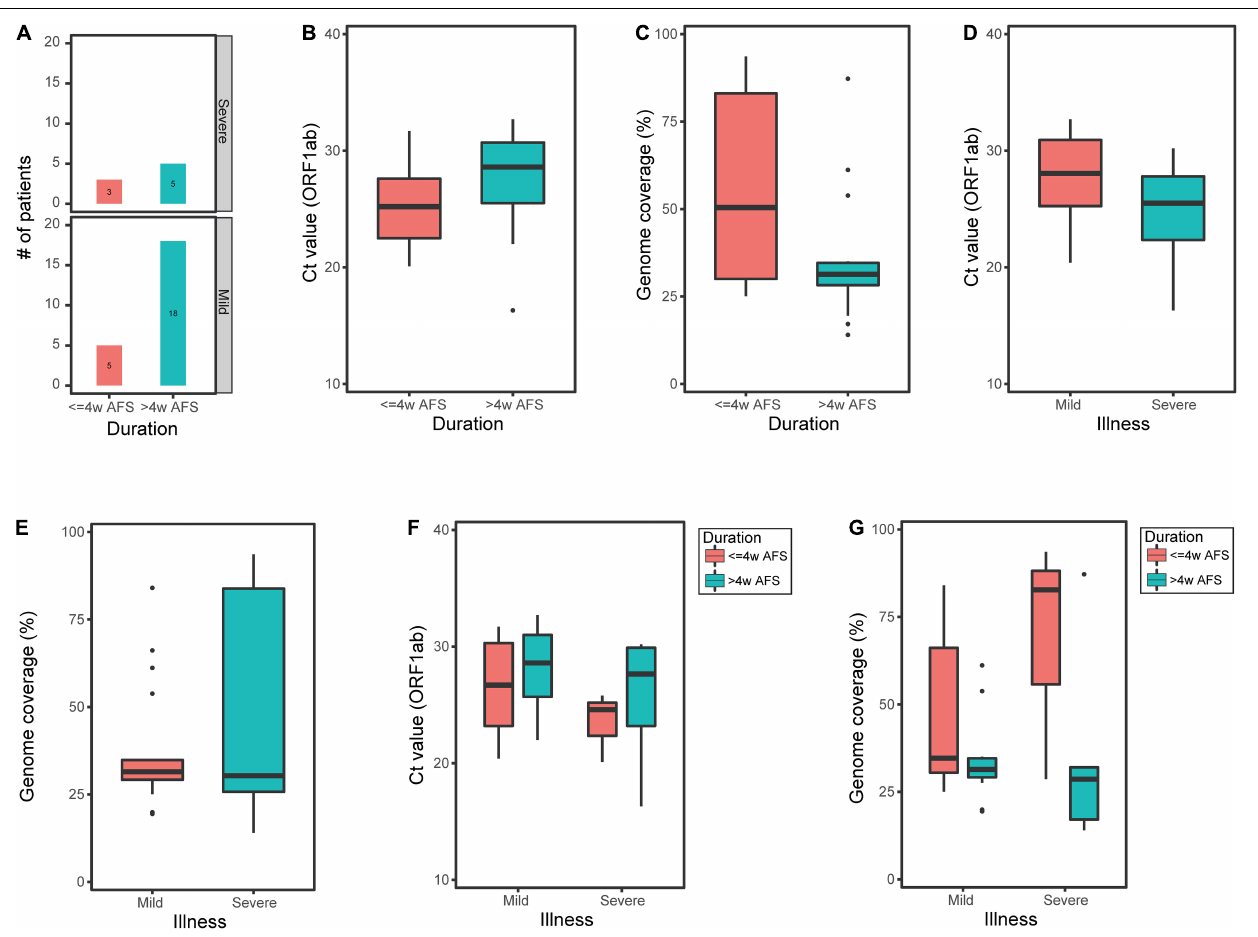
FIGURE 4 | C t value of ORF1ab and reference genome coverage in sputum samples from COVID-19 patients. (A) Number of sputum samples from mild or moderate patients (mild group) and critical or severe patients (severe group) within less or longer than 4 weeks after onset of clinical manifestations ( ≤ 4w AFS or > 4w AFS , respectively). (B,C) C t value and reference genome coverage in sputum samples from patients with ≤ 4w AFS or > 4w AFS. (D,E) C t value and reference genome coverage in sputum samples from mild or severe groups. (F,G) C t value and reference genome coverage in sputum samples in four groups based on